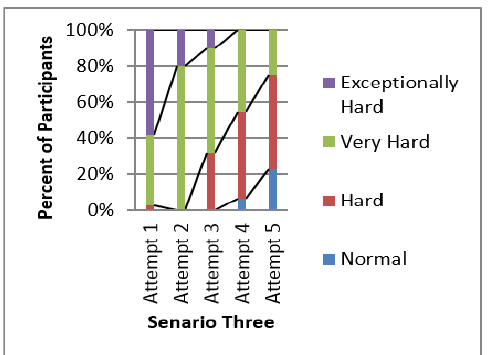
Figure 10. Perceived Difficulty: Scenario